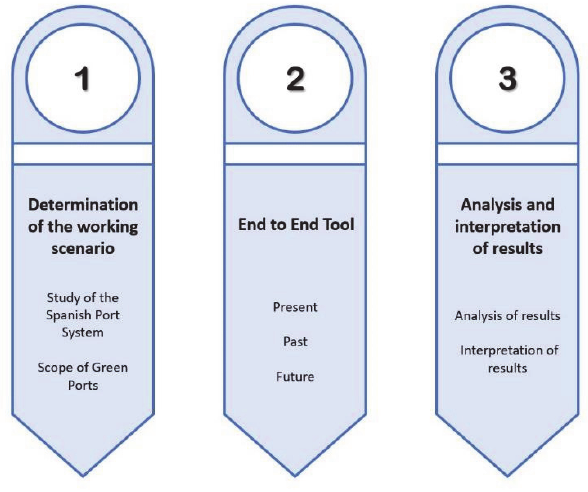
Figure 2. General methodological scheme. Source: own elaboration.